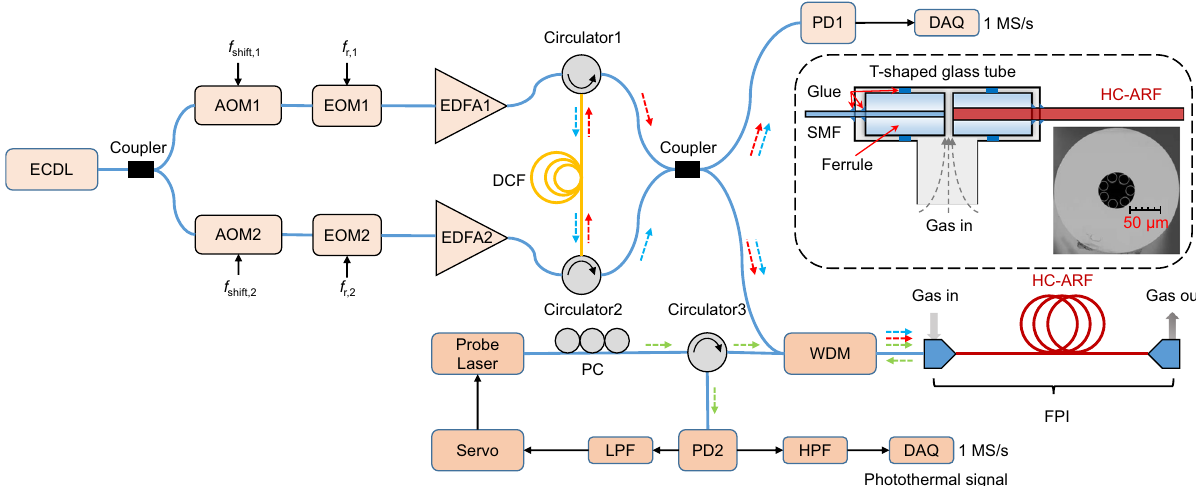
Fig. 2 Schematic of the DC-PTS setup. ECDL external cavity diode laser, AOM acousto-optic modulator, EOM electro-optic modulator, EDFA erbium- doped optical fi ber ampli fi er, DCF dispersion compensation fi ber, PD photodetector, WDM wavelength division multiplexer, PC polarization controller, FPI Fabry-Pérot interferometer, LPF low-pass fi lter, HPF high-pass fi lter, DAQ data acquisition with 16-bit vertical resolution, SMF single-mode fi ber. Inset: scanning electron microscope (SEM) image of the cross-section of the hollow-core anti-resonant fi ber (HC-ARF), and the schematic interface between HC-ARF and SMF. The detailed structure of the FPI is described in Methods section. The pump combs and the probe laser are delivered into the FPI via a WDM. The FPI output of the probe laser carrying the phase modulation information is picked up by the WDM and a circulator (Circulator3). The low- frequency component of the photodetector signal (PD2) is used to lock the probe wavelength to the quadrature point of the interference fringe via a laser servo to obtain the largest frequency-to-amplitude conversion factor (see Supplementary Fig. S2). The PC is used to optimize the contrast of interference fringes. The high-pass fi ltered time-domain photothermal interferograms are digitized continuously at a sampling rate of 1 MS/s and directly Fourier transformed to retrieve the spectrum. Spectral average in the frequency domain is applied to improve the SNR. Note that the DAQ card and all the radio- frequency synthesizers are referenced to a rubidium